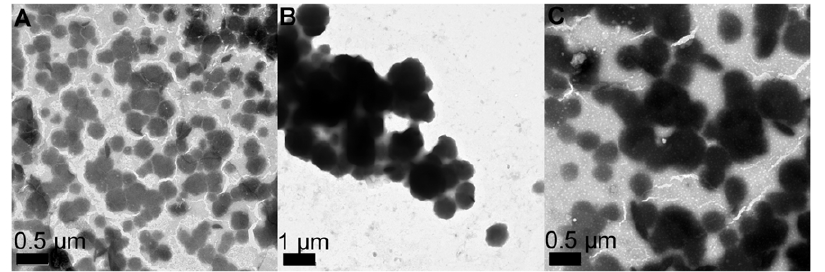
Figure 5. Representive transmission electron micrographs of the lipoplexes prepared from L1 (A), L2 (B) and L3 (C). Lipid/DOPE ratios were 1 : 2 and concentration of DNA was 2 m g, the N/P ratio was 6 for all lipoplexes.